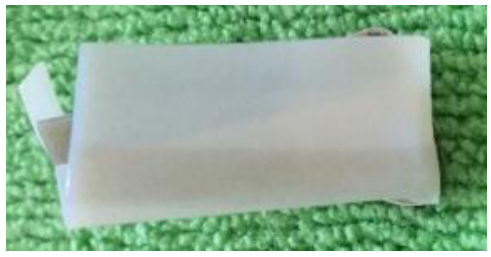
Figure 13. Crossfolding of final structure of method 2.